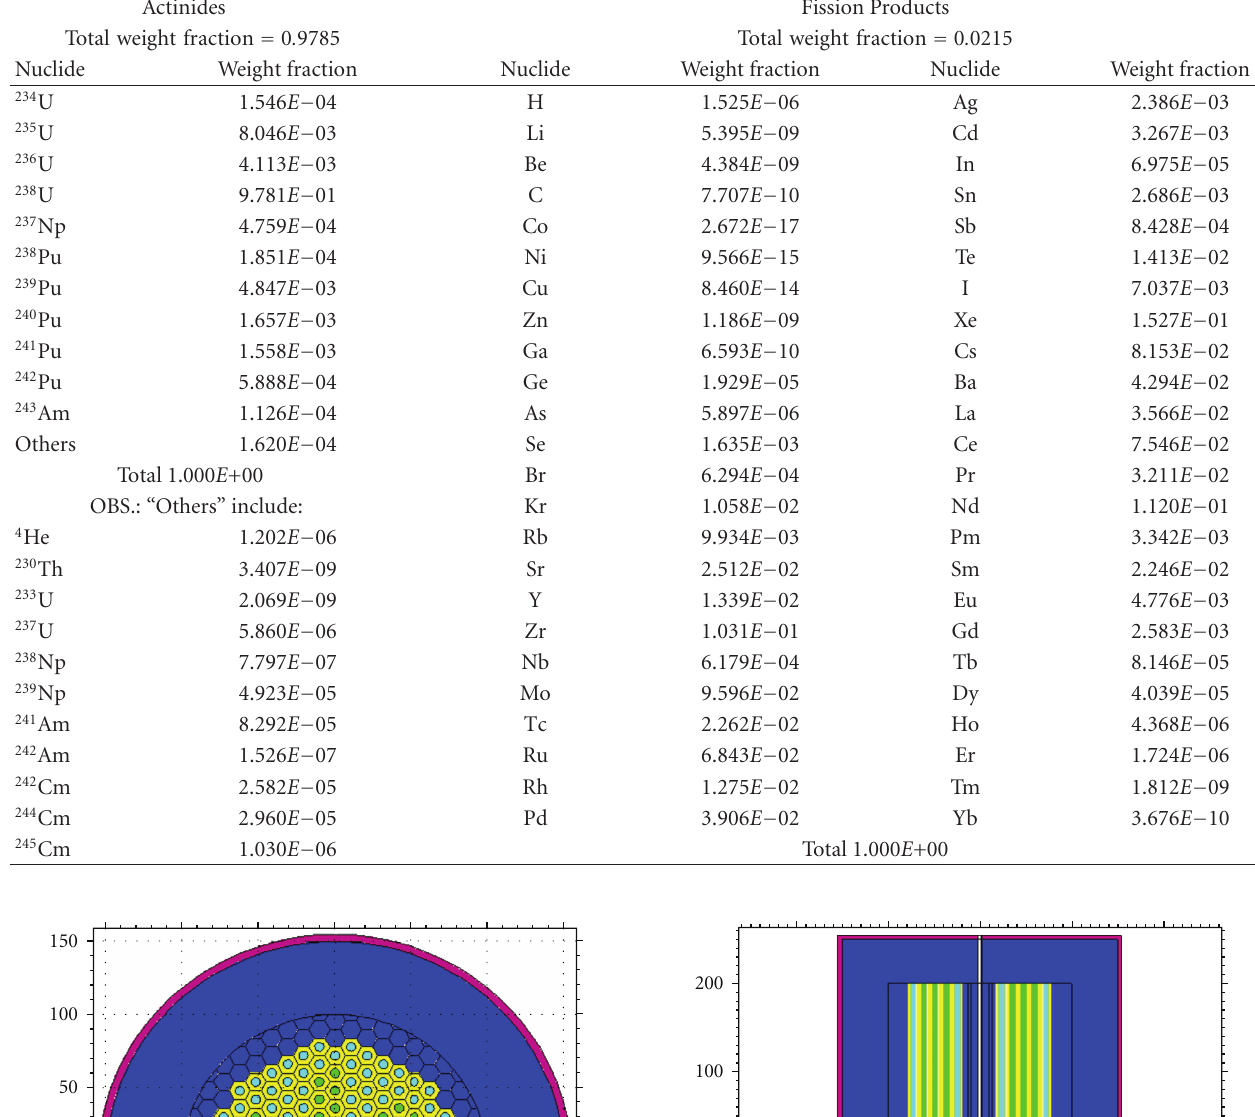
Table 1: UO 2 fuel composition after 33.000 MWd/T.